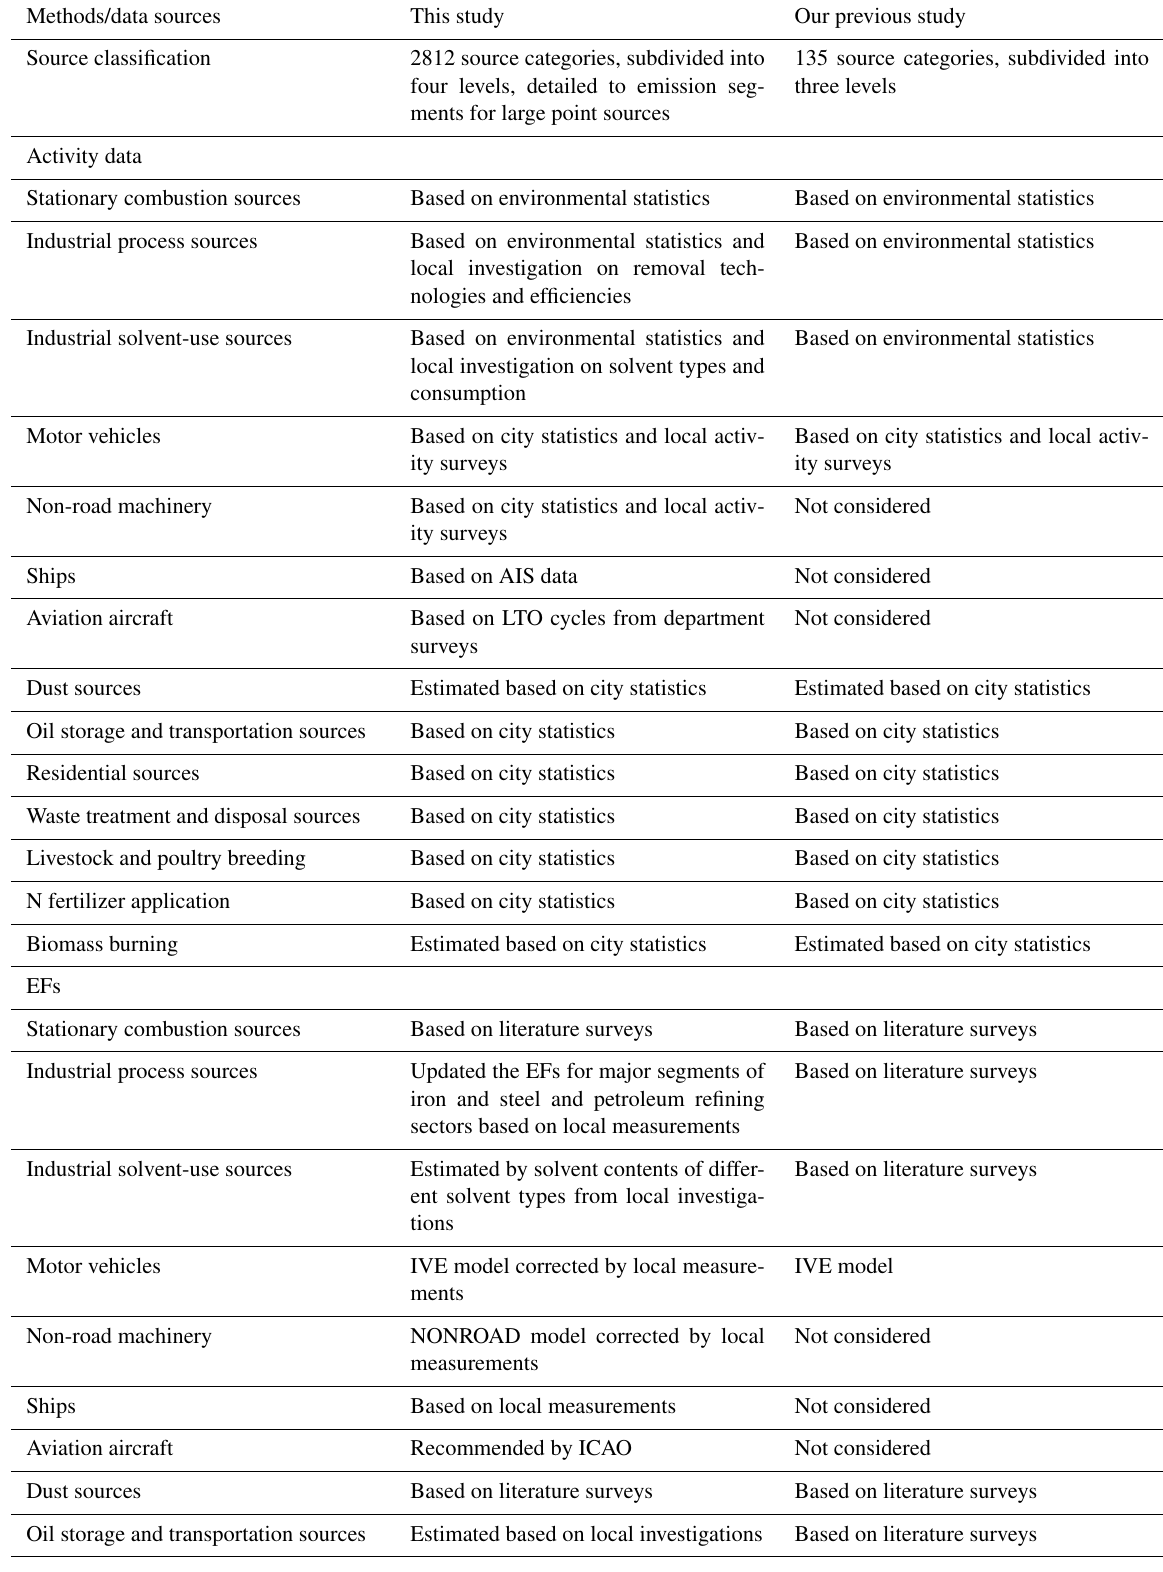
Table 1. Comparison of the methods and data sources in this study with our previous